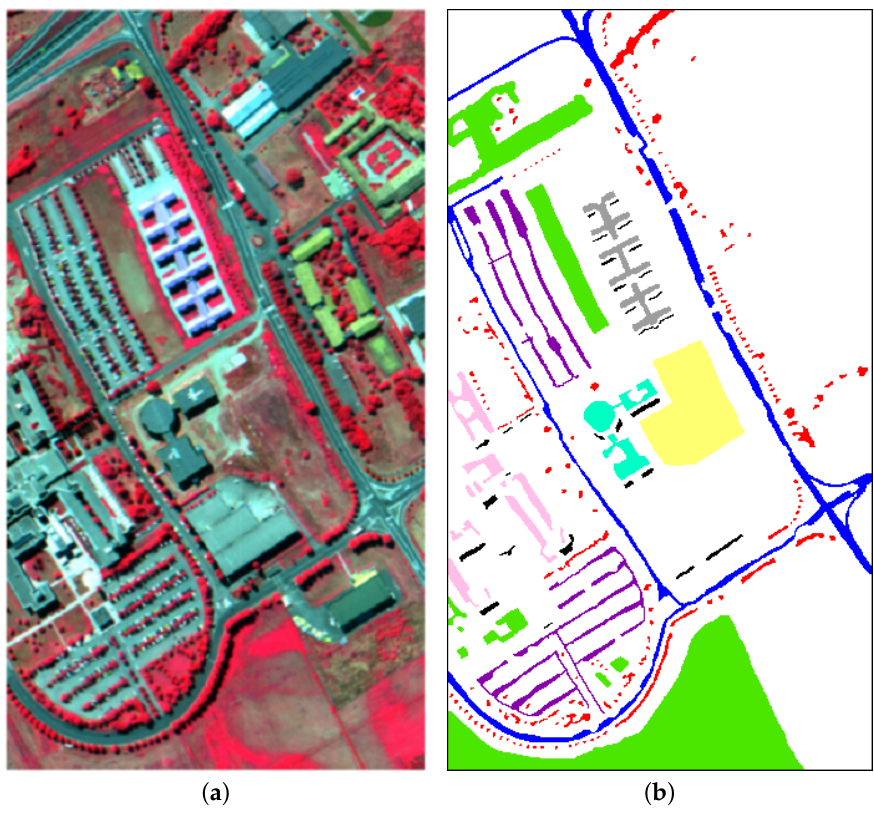
Figure 4. PaviaU. ( a ) False-color image, ( b ) Ground-truth map.